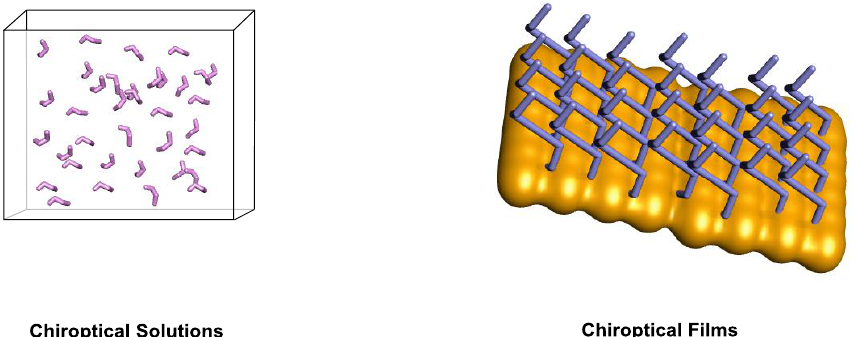
Figure 18. Illustration of chiroptical systems in different states of matter.